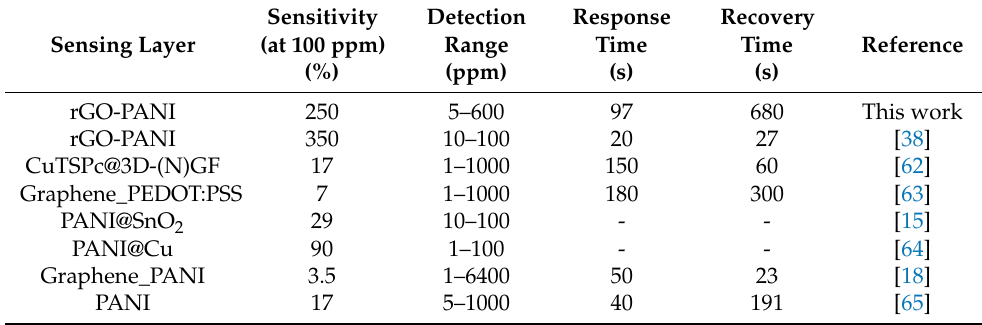
Table 1. Main parameters from NH 3 sensors reported in literature.